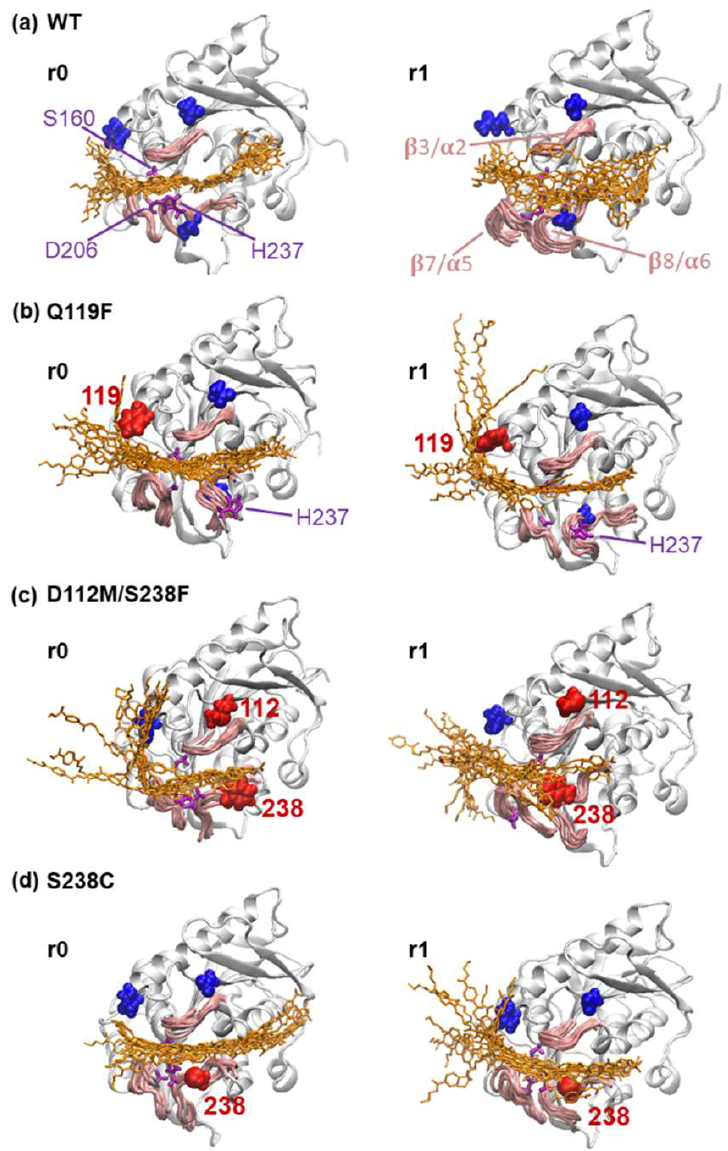
Figure 7. Conformational snapshots of the PETase and PET complex. Three-dimensional ribbon representation of the ( a ) WT PETase and its three mutants, ( b ) Q119F, ( c ) D112M/S238F, and ( d ) S238C, along with the